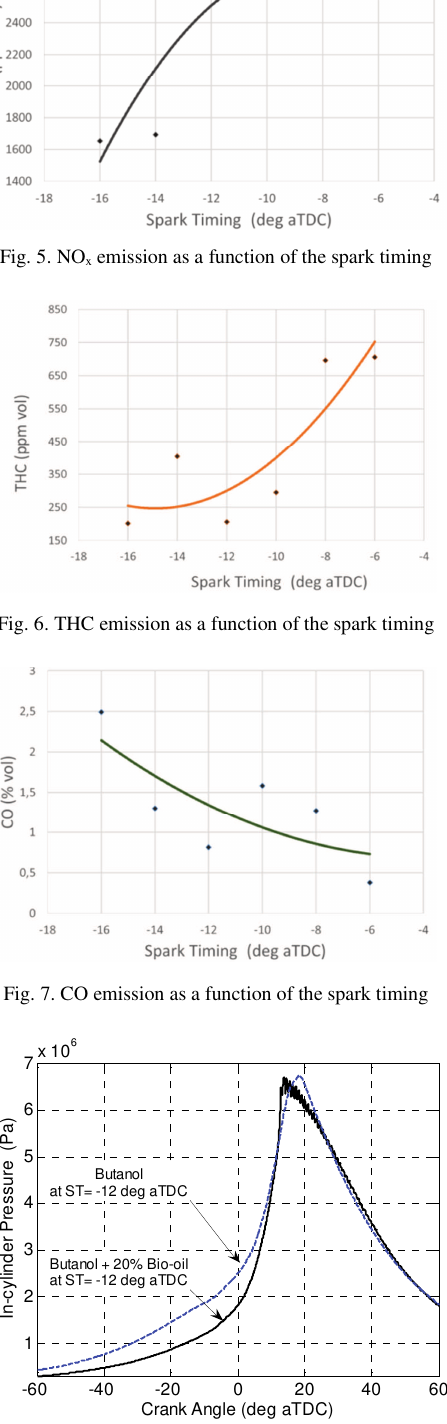
Fig. 8. In-cylinder pressure vs. crank angle